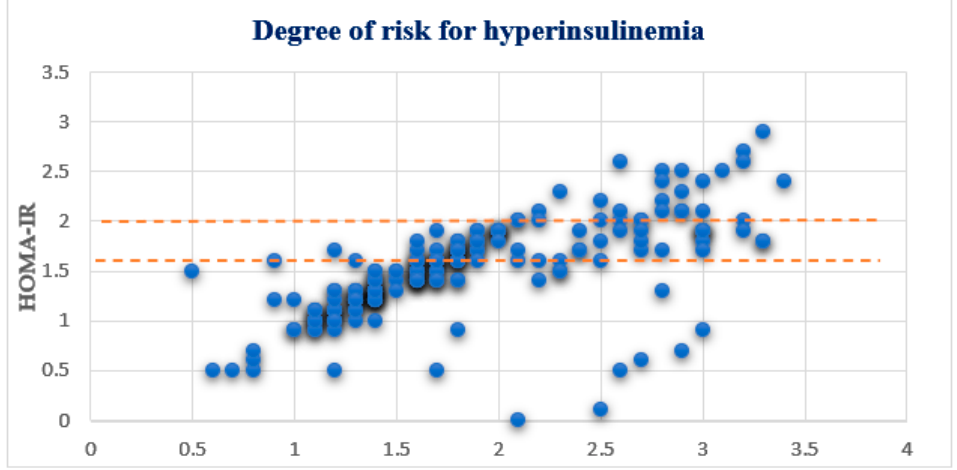
Figure 4. Degree of risk for hyperinsulinemia.